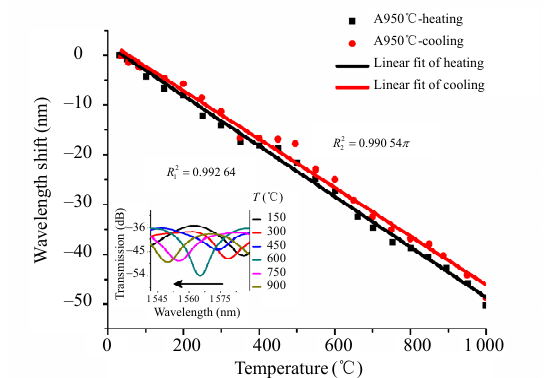
Fig. 8 Wavelength shift versus temperature for the sensor after the 0.5-hour annealing process.